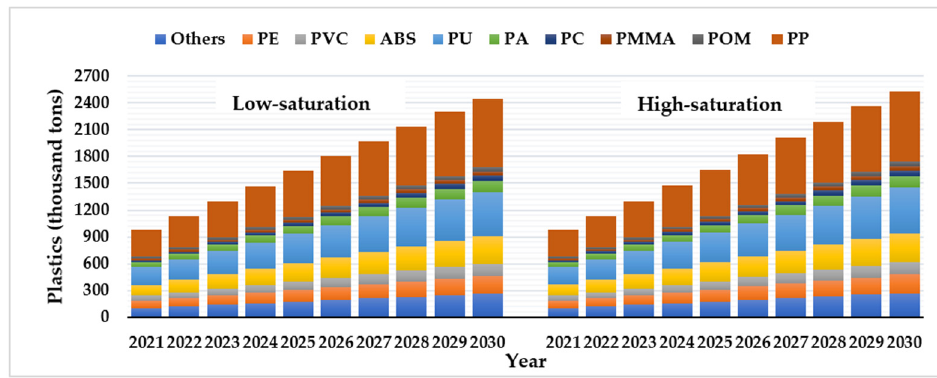
Figure 4. Various types of recyclable plastics from EoL passenger vehicles from 2021 to 2030.